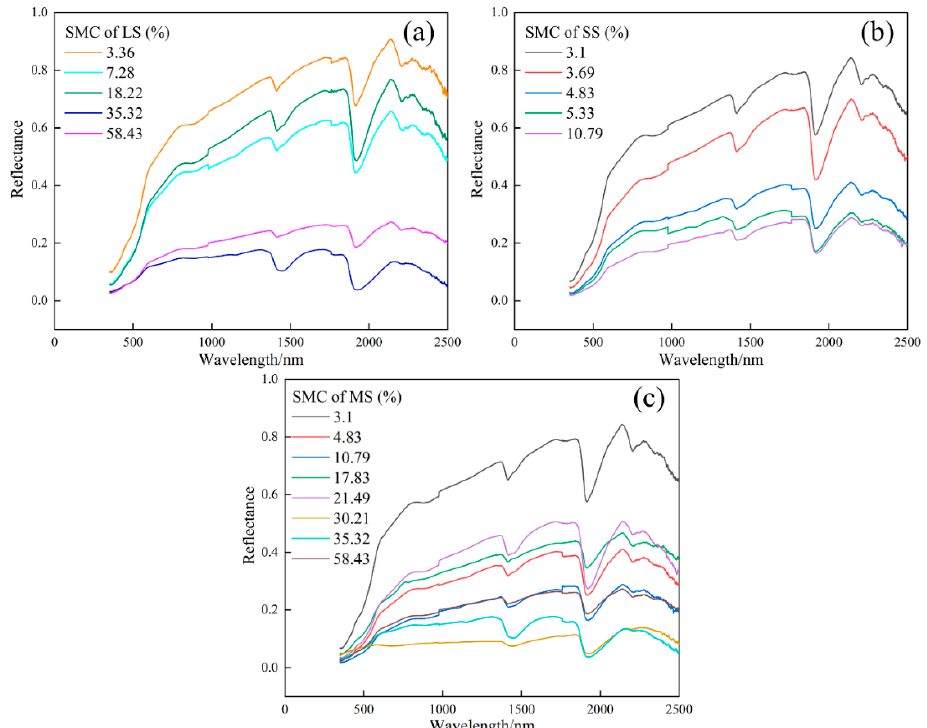
Figure 4. Hyperspectral curves of different soil types: ( a ) LS; ( b ) SS; ( c ) MS.